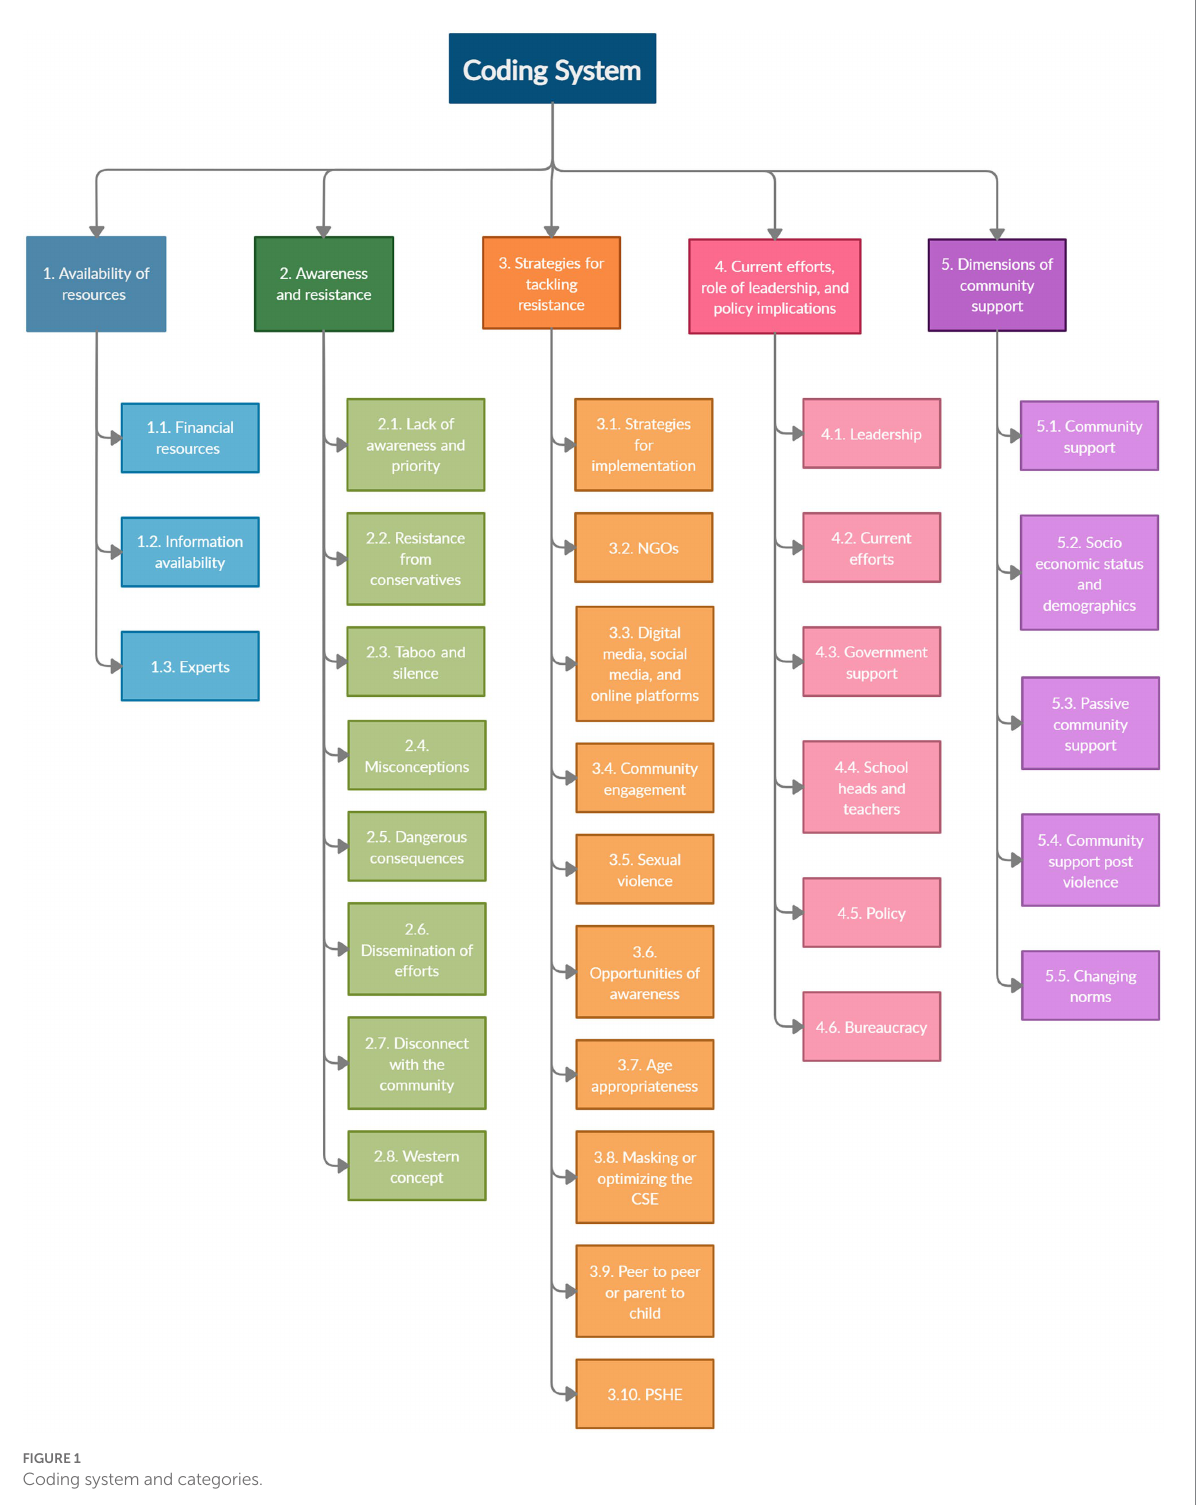
FIGURE 1 Coding system and